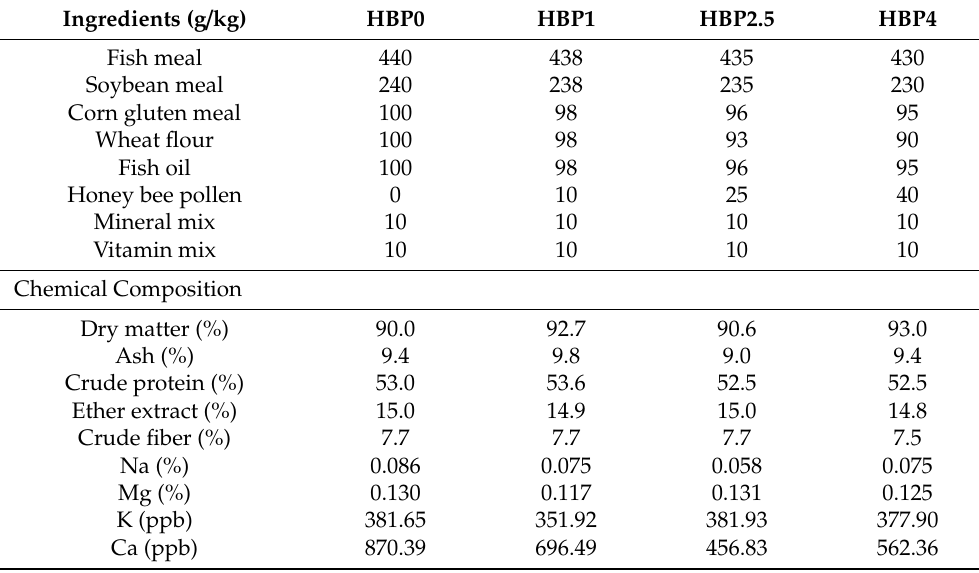
Table 1. Ingredients and chemical composition of experimental diets for